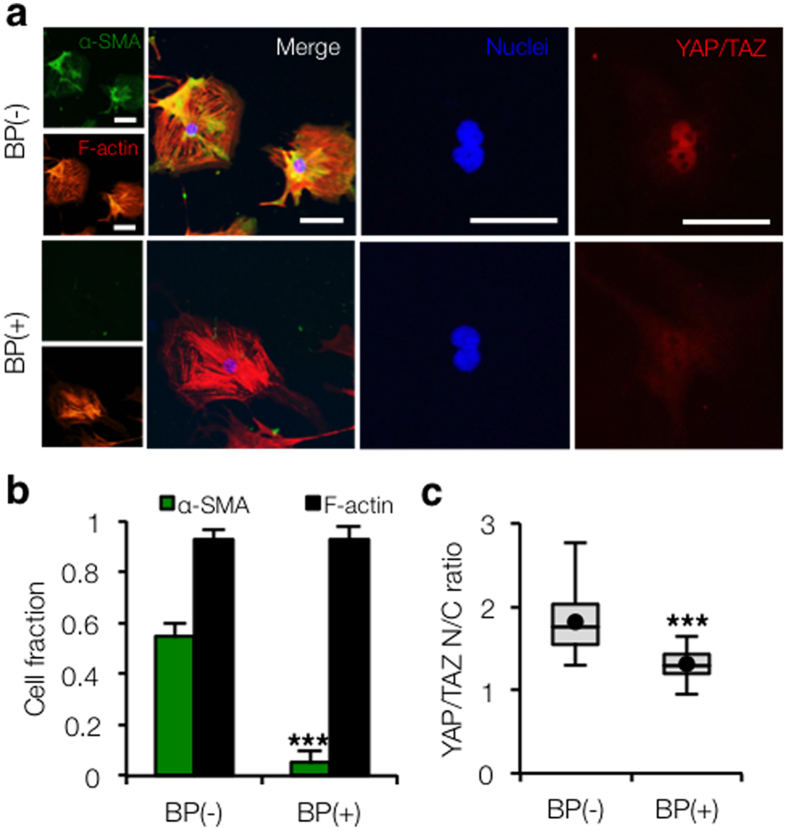
Blocking α-SMA polymerization results in reduced YAP/TAZ nuclear shuttling.(a) Stellate cells were seeded on soft gels that were stiffened after 3 days and cultured in normal media (BP(−)) or media supplemented with α-SMA blocking peptide (25 μg/mL, BP(+)) for an additional 4 days. The blocking peptide almost completely abrogated α-SMA expression without impacting other filamentous actin, but reduced nuclear YAP/TAZ accumulation. Scale bars: 50 μm. (b) Immunostaining quantification indicates that α-SMA blocking does not affect the fraction of cells displaying F-actin stress fibers (n > 30 cells per group, error bars represent s.e.m.). (c) Tukey box plot of YAP/TAZ nuclear to cytoplasmic intensity ratio demonstrated significant reduction in YAP/TAZ nuclear localization in BP(+) group (n > 30 cells per group). ***P < 0.001.